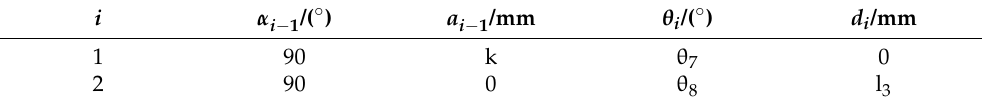
Table 2. D-H parameters of 2R limb.